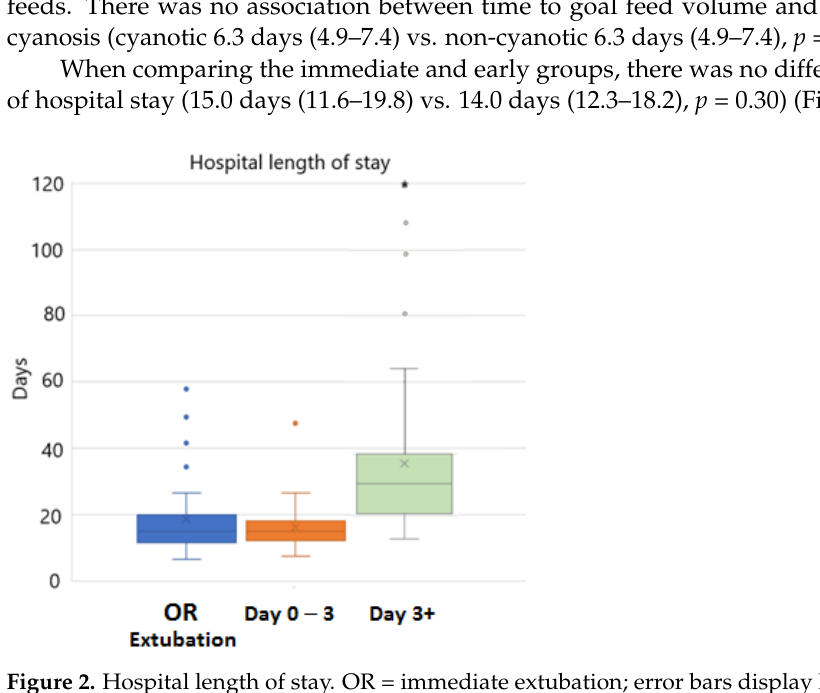
Figure 2. Hospital length of stay. OR = immediate extubation; error bars display IQR. * represents one outlier with hospital stay >120 days.